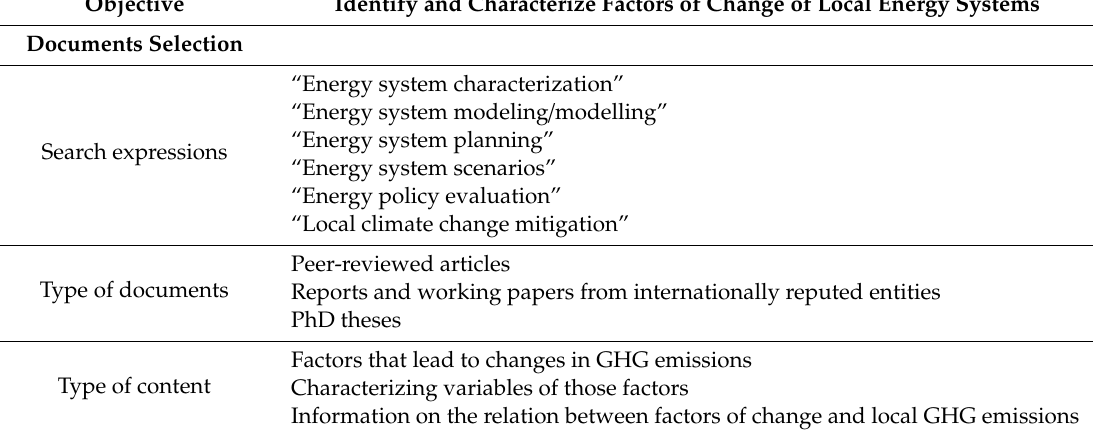
Table 1. Systematic literature review specifications.